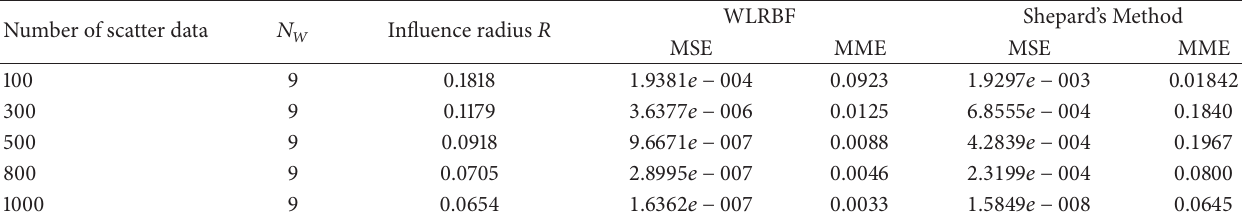
Table 3: The comparison of MSE and MME of WLRBF method and Shepard method for the same scattered points. Number of scatter data